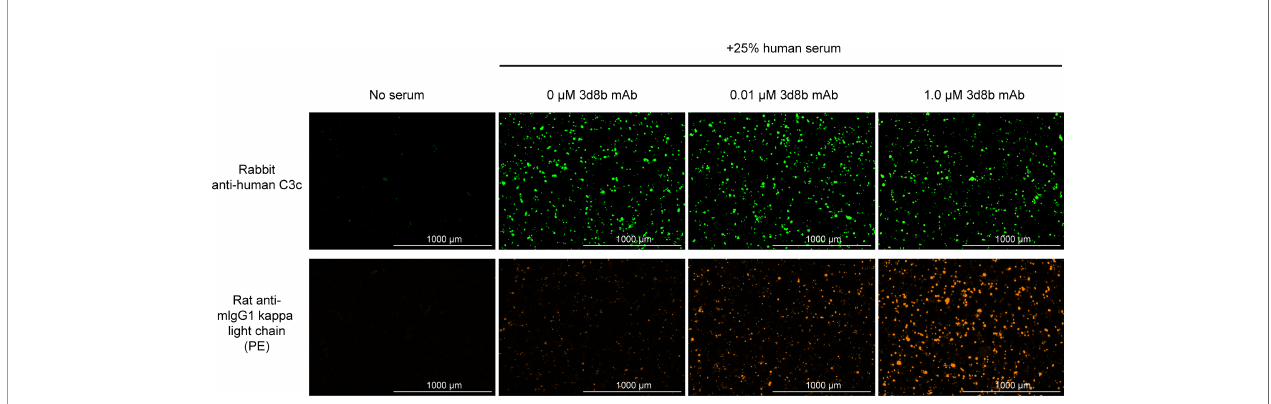
FIGURE 4 | Complement activation and C3d deposition in the HMEC assay. Anti-C3 fragment (green) and anti-3d8b mAb (red) immunostaining of injured HMEC cells with human serum complement activation. Immunostaining is shown with or without human serum treatment and with or without co-culture of anti-C3d mAb, 3d8b, at the